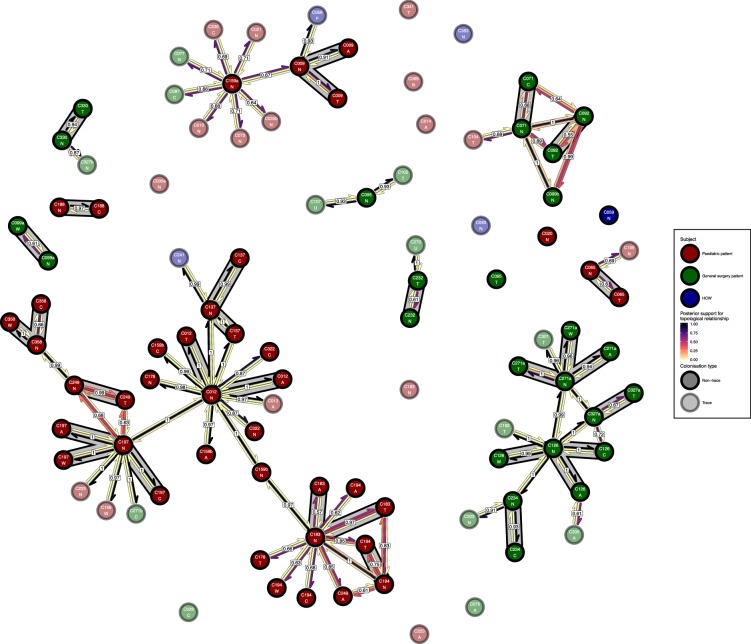
The phyloscanner host relationship diagram for the body site analysis, with trace colonisations included.Each node represents all the sequences for one colonisation of one body site. Node fill colours designate patients in the two hospital ICUs and the HCWs and nodes with faded colours representing trace colonisations. Edges appear where colonisations share a relationship with posterior support of at least 0.5 and consist of three elements: arrows representing transmission in either direction and a central line segment representing the ‘complex’ topological relationship, which is indicative of transmission but the direction is ambiguous. Each of these is coloured according to the proportion of posterior trees showing the corresponding relationship. Edges are also labelled with the overall posterior support for any topology suggesting transmission, and edges connecting colonisations from sites from the same subject have a grey background. Nodes are annotated with colonisation IDs and a code for body site: A = axilla, C = endotracheal suction, F = fingertips, N = nose, T = throat, U = urine, W = wound.